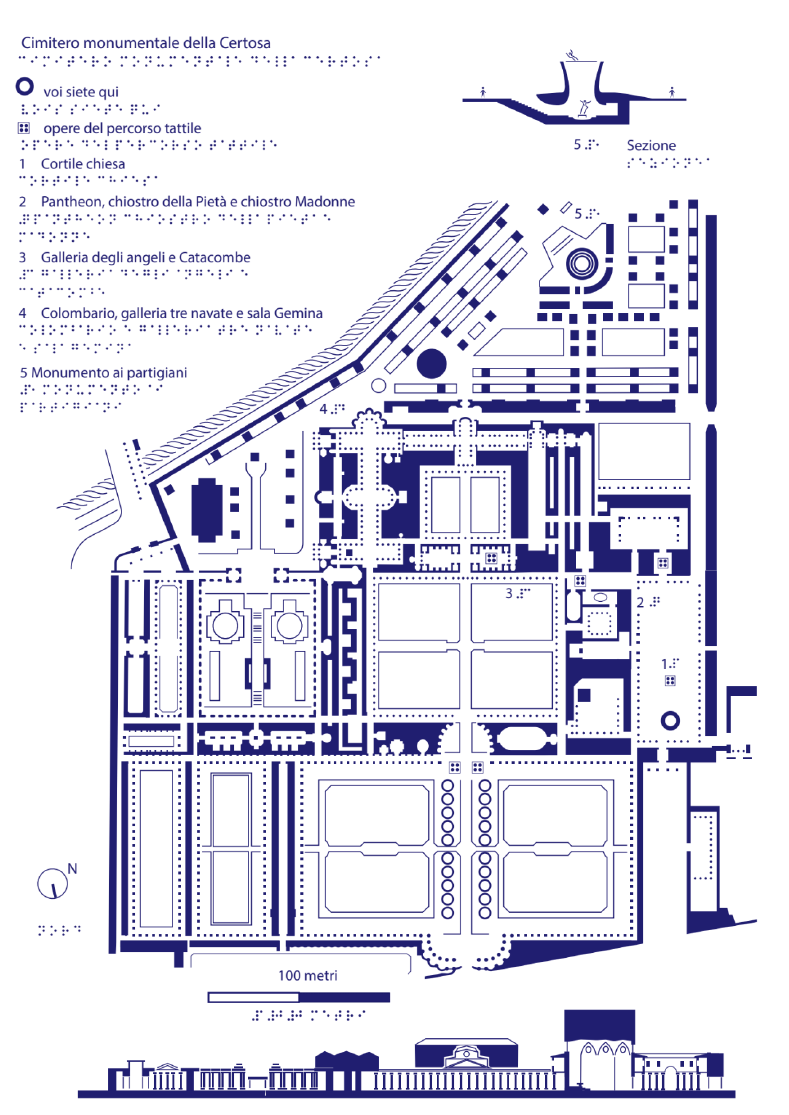
FIG. 2 Orientation and mobility tactile map design for the Monumental Museum of the Certosa of